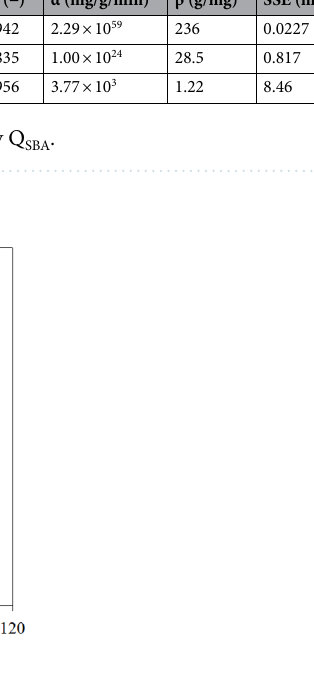
Figure 3. Effect of initial concentration of CBZ on its adsorption by Q SBA .